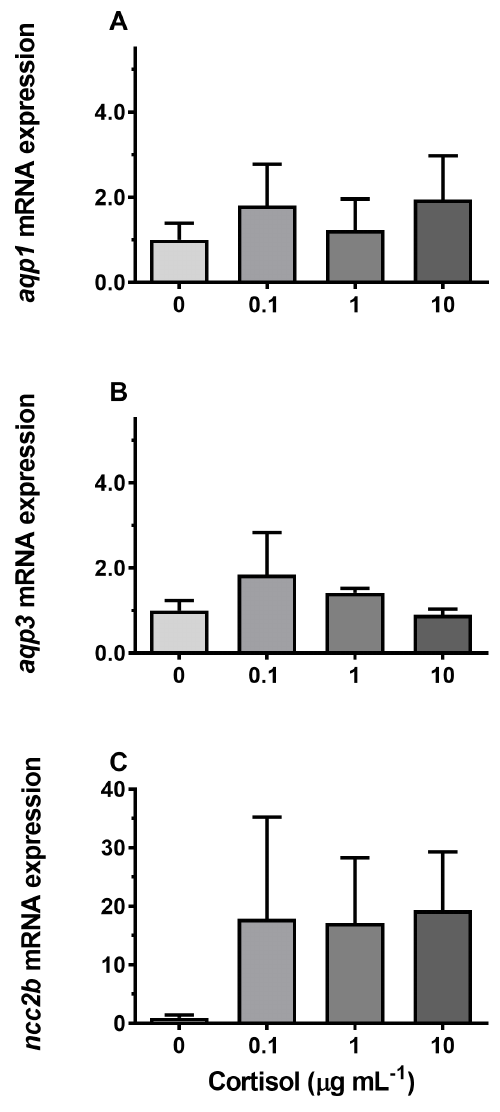
Figure 10. ( A – C ) Ex vivo dose–response of cortisol (0, 0.1, 1, and 10 µ g mL − 1 ) on AQP1 , AQP3 , and NCC2b expression in FW medaka gills. Gill explants were incubated for 18 h at room temperature. Expression of each target was normalized to the geometric mean of the three normalization genes: EF1a , bact , and RPL7 and presented relative to the control. Data are presented as mean ± standard error of the mean (n = 4–6). No significant e ff ects were observed (one-way ANOVA, P <